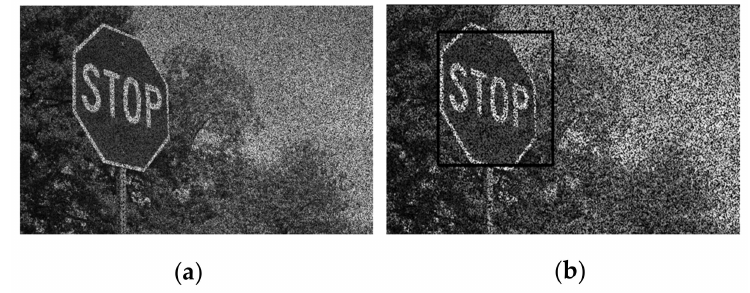
Figure 11. ( a ) Noisy image; ( b ) Detected image.